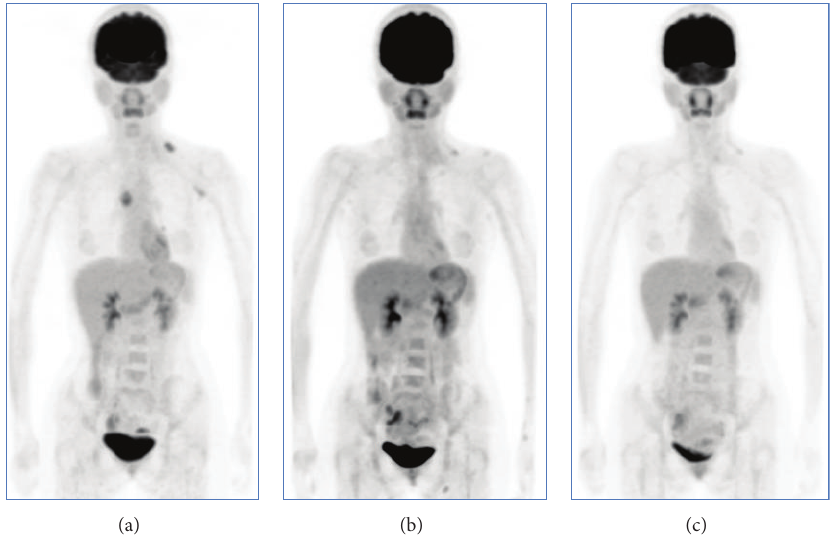
Figure 3: Serial PET/CT images before and after brentuximab vedotin treatment. (a) Before treatment, showing mediastinal tumor progression, with metastases to left lung, left axillary, and supraclavicular lymph nodes. (b) Near-complete remission after 4 cycles of treatment, with a faint uptake over left lower neck. (c) Complete remission after 9 cycles of